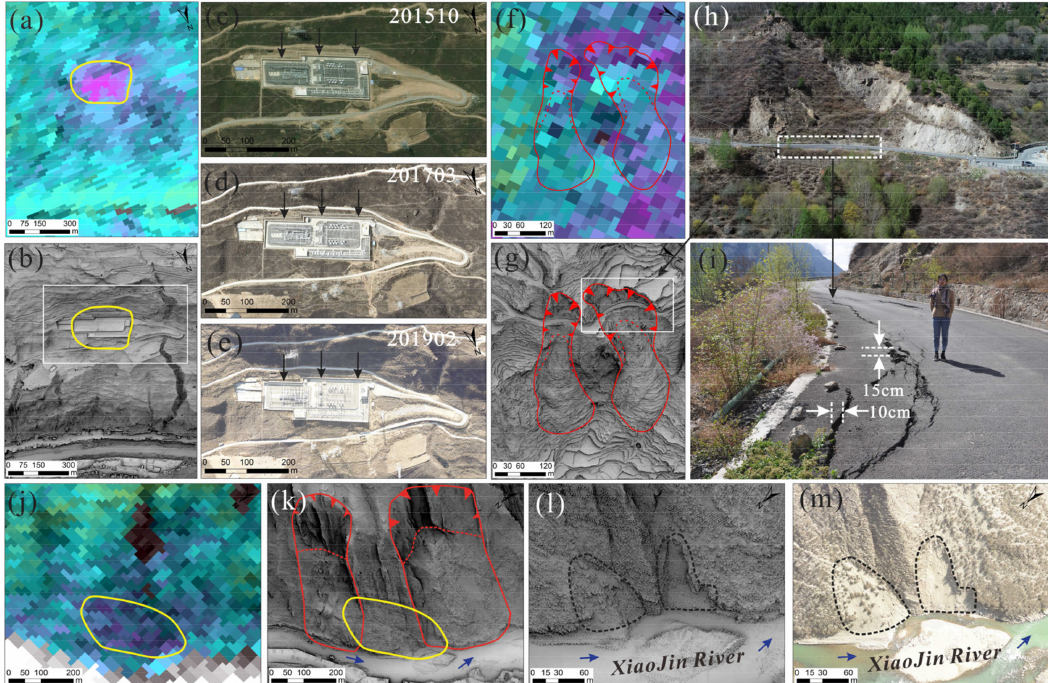
Figure 9. Combination of InSAR and LiDAR technologies to detect landslides: ( a ) stacking InSAR differential interferogram and the interpreted deformation zone; ( b ) the corresponding LiDAR-SVF image; ( c – e ) Optical images corresponding to October 2015, March 2017, and February 2019, respectively; ( f ) stacking InSAR differential interferogram with suspected landslide boundaries delineated according to those identified in LiDAR images; ( g ) LiDAR-SVF image and two interpreted landslides; ( h ) a photo near the landslide area; ( i ) cracks in the highway caused by landslide activities; ( j ) stacking InSAR differential interferogram and an area with insignificant deformation; ( k ) the corresponding SVF image and interpreted landslide boundaries; ( l ) an enlarged SVF image of the deformed area; ( m ) an enlarged optical image of the deformed